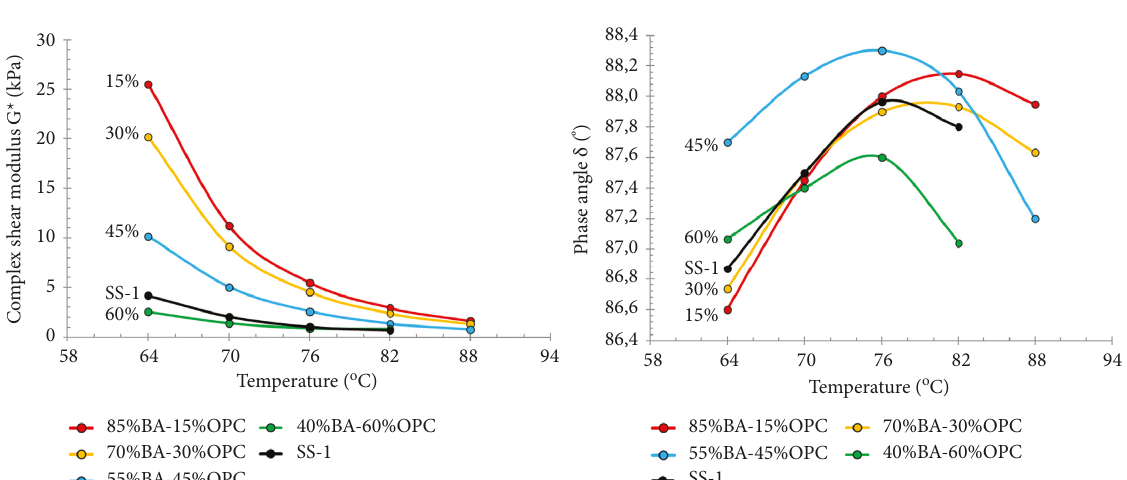
Figure 3: Research plan flowchart.